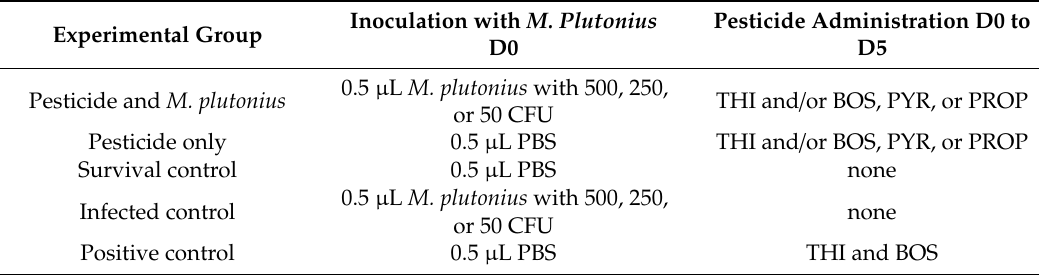
Table 1. Experimental design of in vitro model for testing e ff ects of pesticides on larval mortality from European foulbrood. On day 0 (D0) of the experiment, larvae received 0.5 µ L phosphate bu ff ered saline (PBS) or 0.5 µ L of a pure culture of Melissococcus plutonius diluted in PBS to contain 500, 250, or 50 colony forming units (CFU). From day 0 to day 5, larvae were administered control diet or diet contaminated with the pesticides thiamethoxam (THI) and / or boscalid (BOS), pyrimethanil (PYR), or propiconazole (PROP). Larval survival was monitored daily until day 6. Inoculation with M. Plutonius Pesticide Administration D0 to Experimental Group D0 D5 0.5 µ L M. plutonius with 500, 250, Pesticide and M. plutonius THI and / or BOS, PYR, or PROP or 50 CFU Pesticide only 0.5 µ L PBS THI and / or BOS, PYR, or PROP Survival control 0.5 µ L PBS none Infected control none or 50 CFU 0.5 µ L